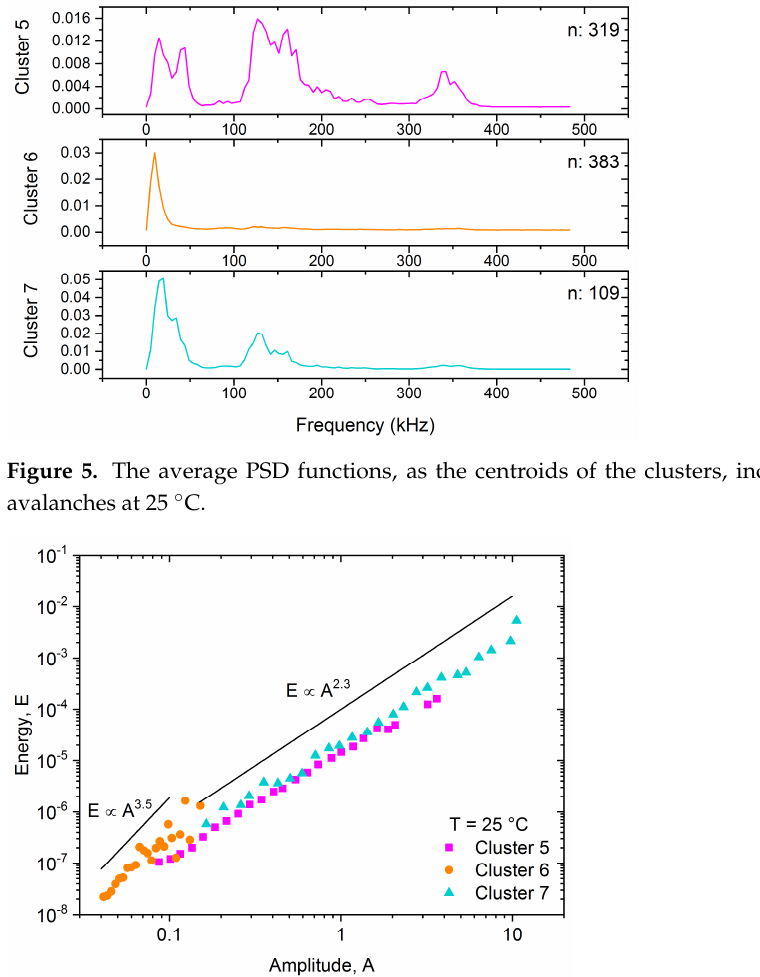
Figure 6. Energy vs. amplitude function for all clusters obtained at 25 ◦ C. The exponent of the scaling relation is in the acceptable range only for Clusters 5 and 7.